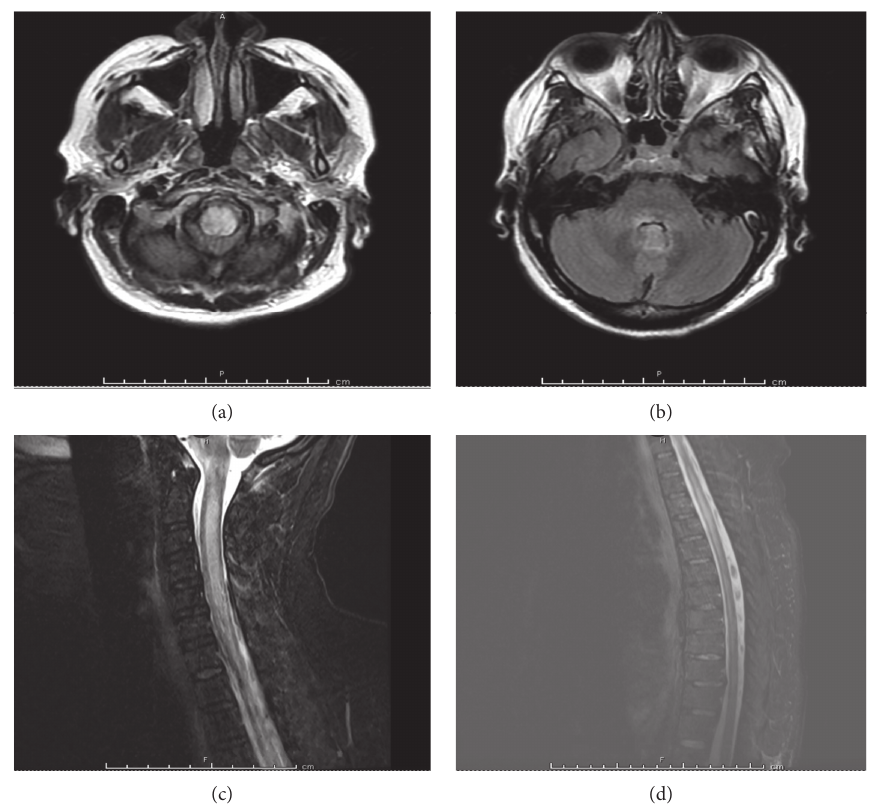
Figure 3: FLAIR brain MRI of a 48-year-old Hispanic woman with SLE with noted medullary lesion extending to the periaqueductal gray matter (a, b) and with diffuse lesions in the C and T spine (c,